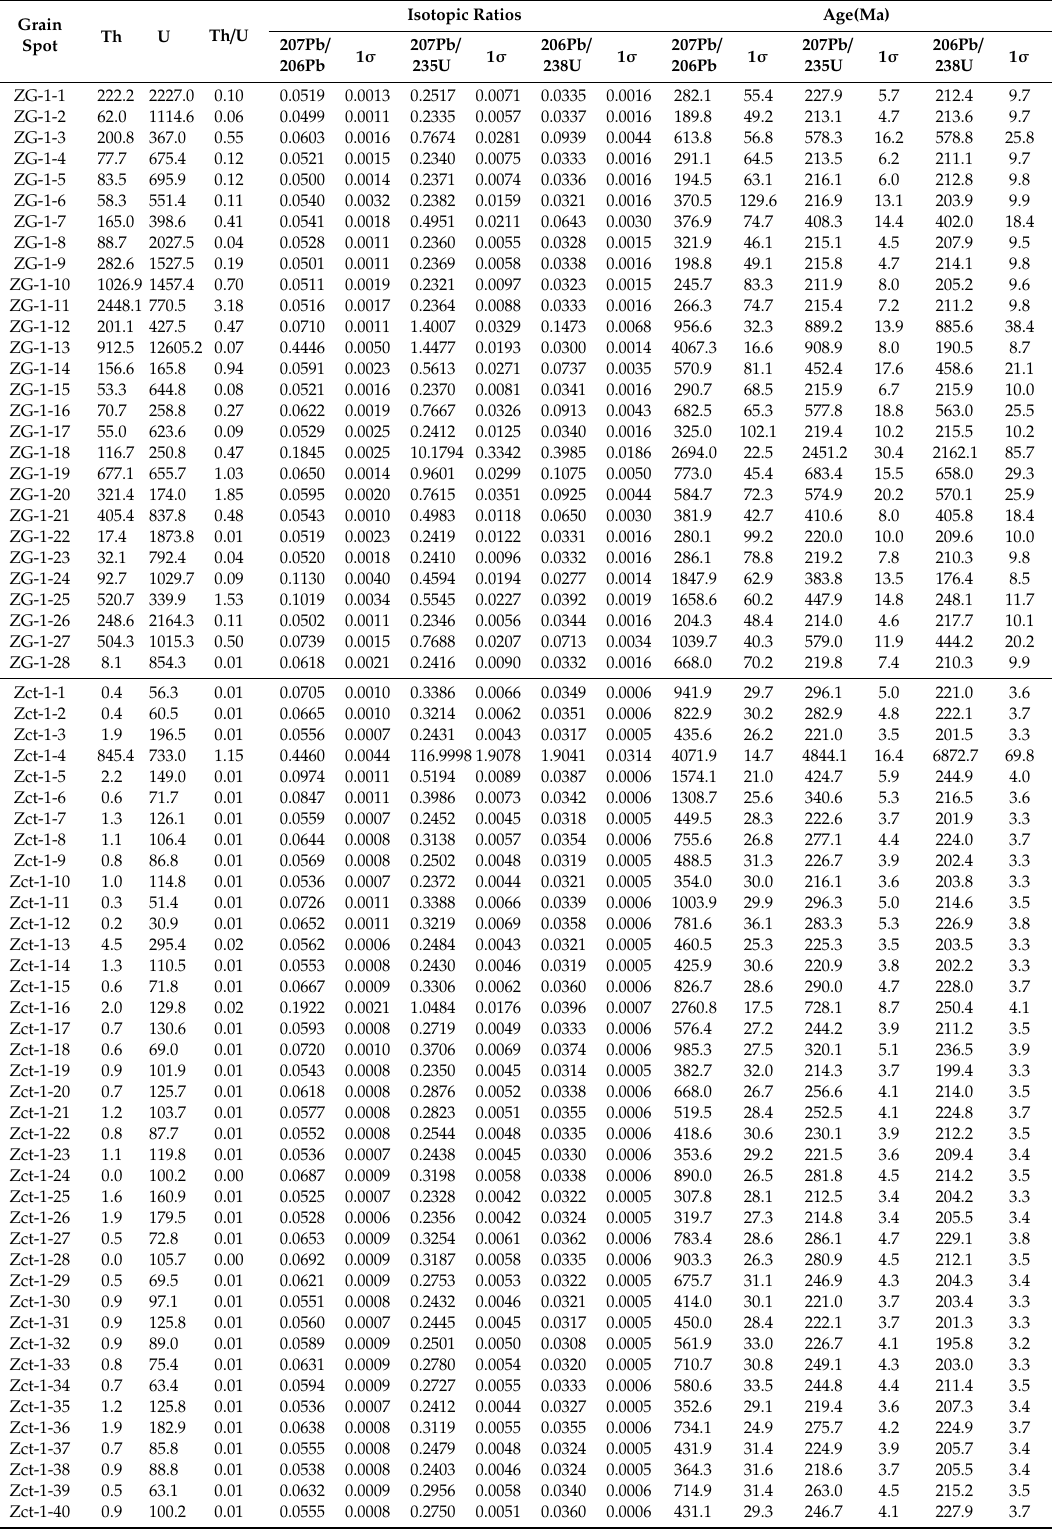
Table A2. LA-ICP-MS U–Pb data for zircons and columbite–tantalites from the Zhawulong